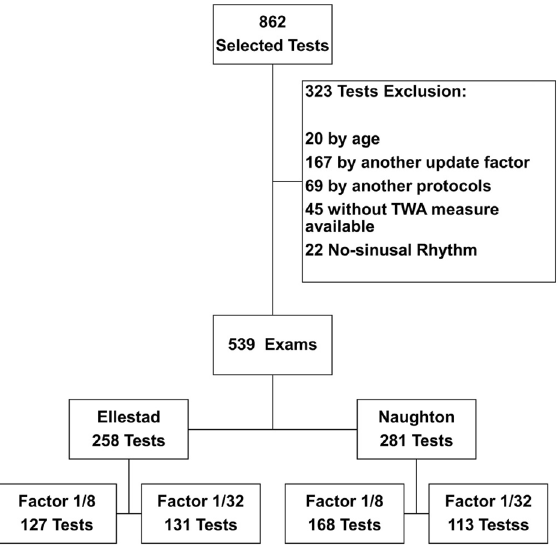
Figure 1. Study flowchart and distribution of the number of tests per